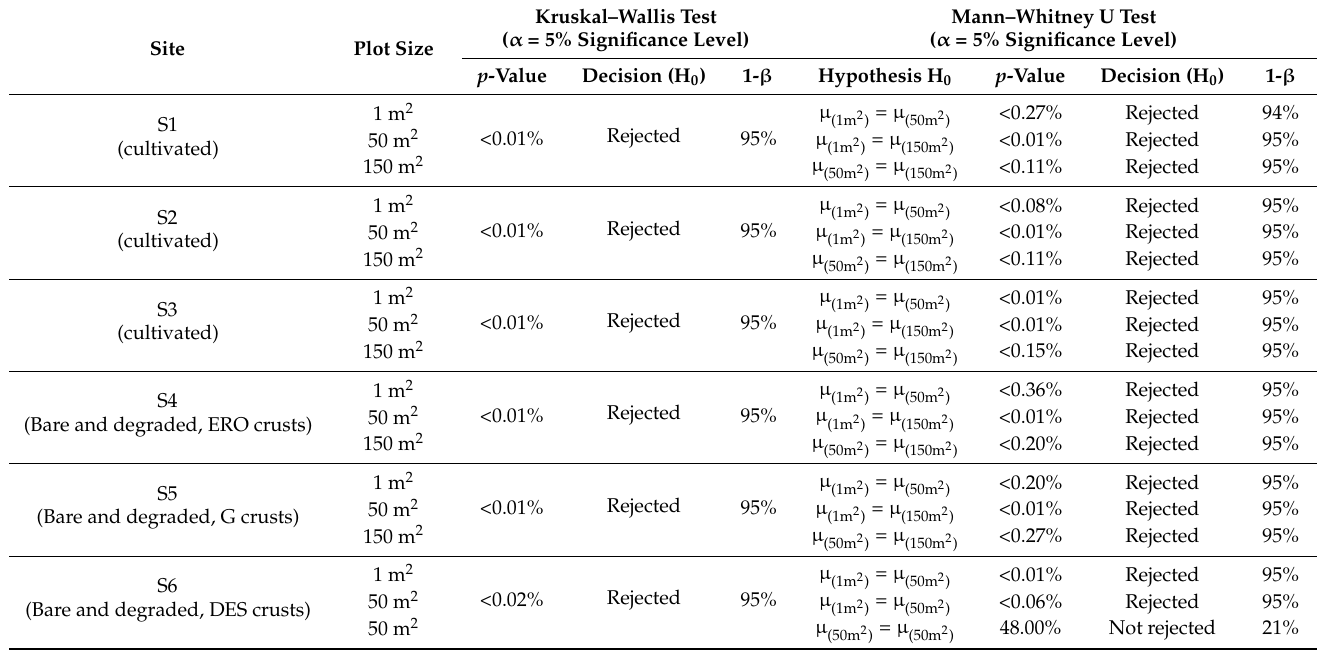
Table 4. Analysis of the plot size effect on soil loss values in the Tougou watershed.